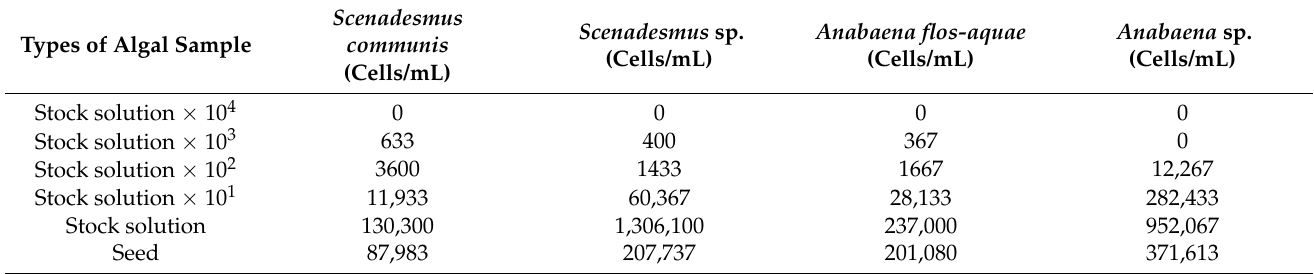
Table 2. Results of cell count for algal samples used in the study (SDC; Scenadesmus communis stock solution; SDS; Scenadesmus sp. stock solution; ABS; Anabaena flos-aquae stock solution; ABS; Anabaena sp. stock solution; numbered in descending order of concentration).